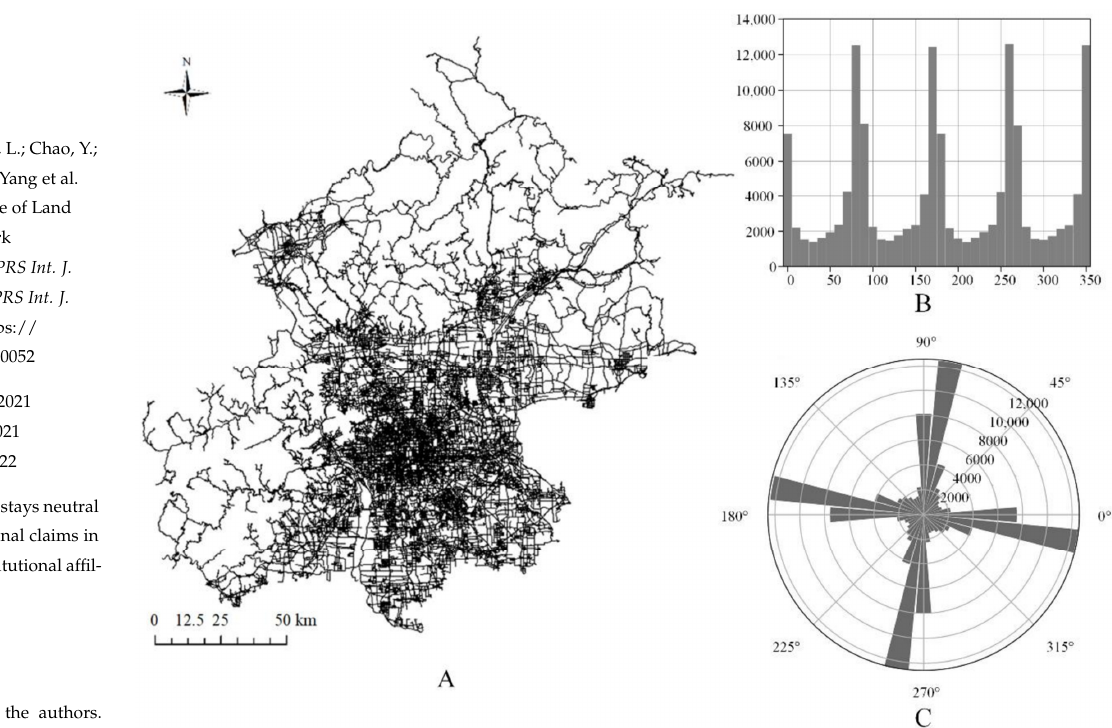
Figure 2. ( A ) Street network in Beijing. ( B ) Street orientation histogram of Beijing, where the horizontal coordinates indicate the orientation angles, and the vertical coordinates indicate the frequency of a street falling into the corresponding bin. ( C ) Street orientation rose illustration of Beijing, where the outer side of the circle represents the street orientation, and the inner data are the same as the vertical coordinate in ( B ).